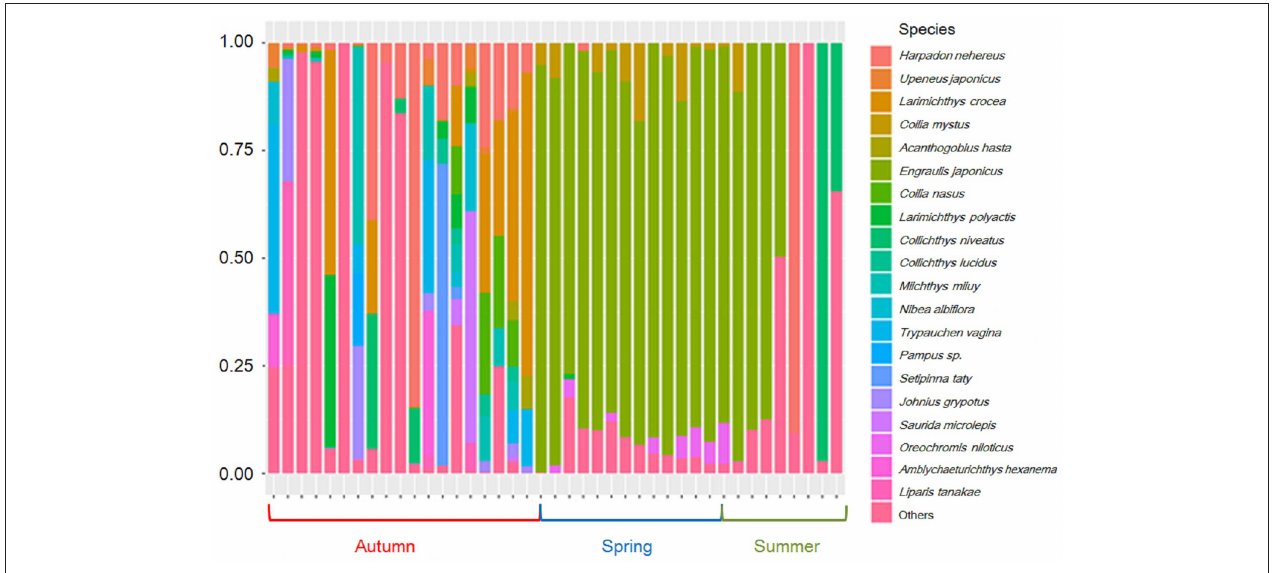
FIGURE 2 | Species distribution in three seasons.